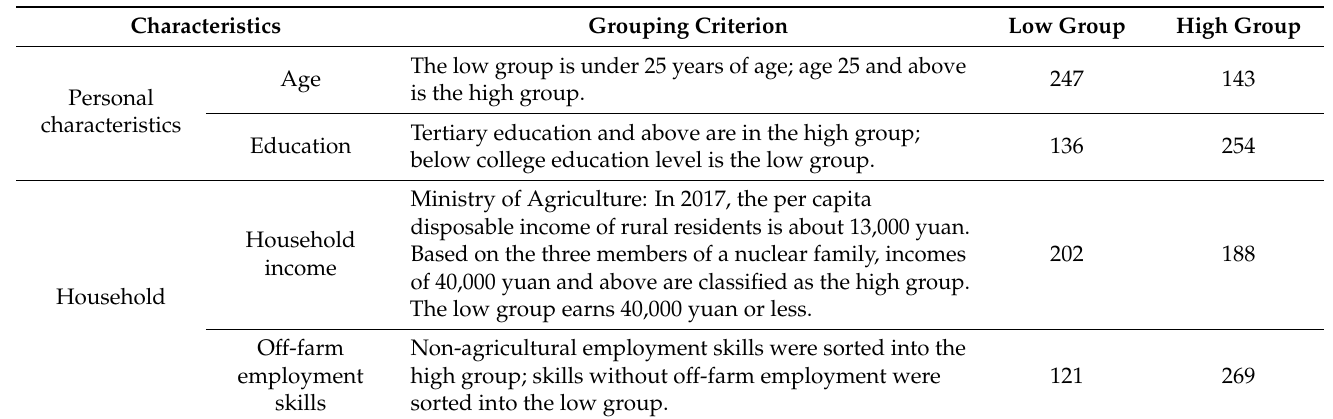
Table 6. Grouping according to sample characteristics. Characteristics Grouping Criterion Low Group High